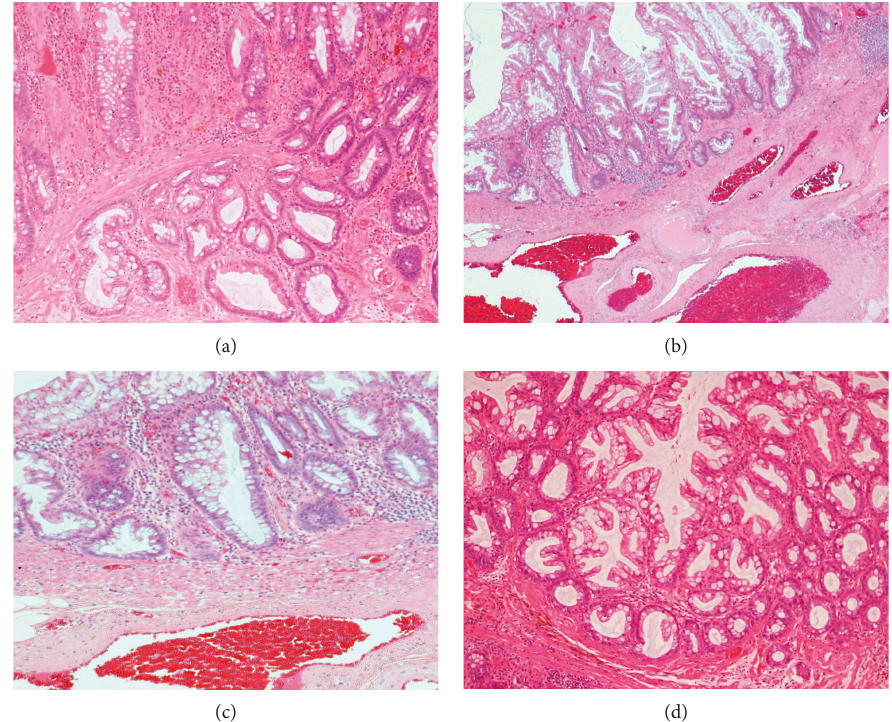
Figure 1: Hyperplastic polyp, with prolapse e ff ect, characterized by dilated and congested submucosal blood vessels, thickening of the muscularis mucosae, and upward extension from the hypertrophic and splayed muscularis mucosae, with dilated crypts (a, b). Horizontal extension of crypt bases along the muscularis mucosae can be seen, mimicking the architecturally distorted, dilated, and/or horizontally branched crypts of SSL/Ps (c,